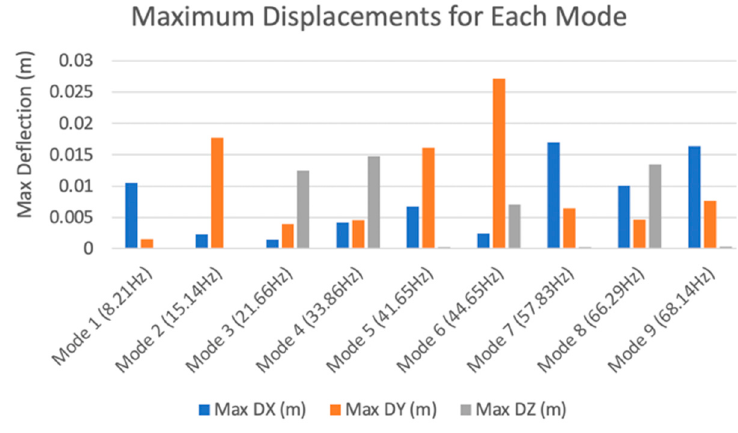
Figure 11. Maximum vertical and lateral nodal displacement for each mode.